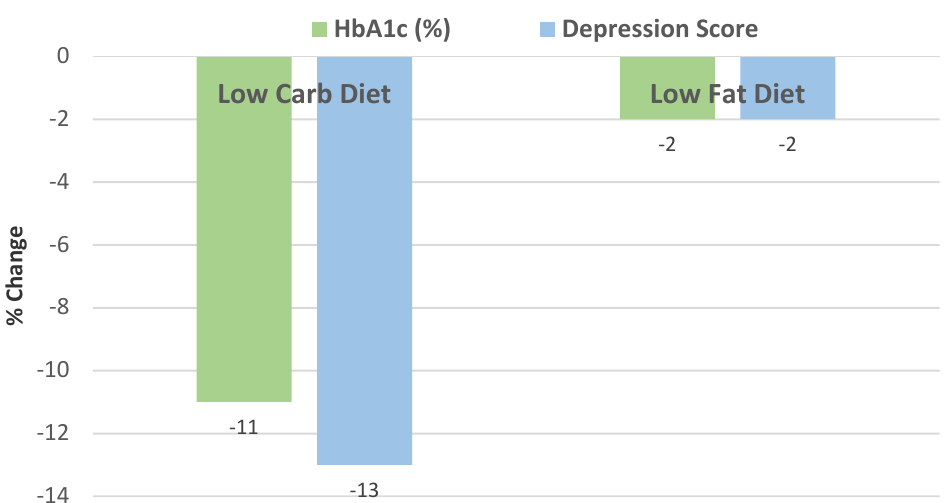
Figure 36. Comparison of HbA1c and the depression scores between almond low-carbohydrate and low-fat diets between baseline and 12 weeks (for almonds, p < 0.01 for both) [59].